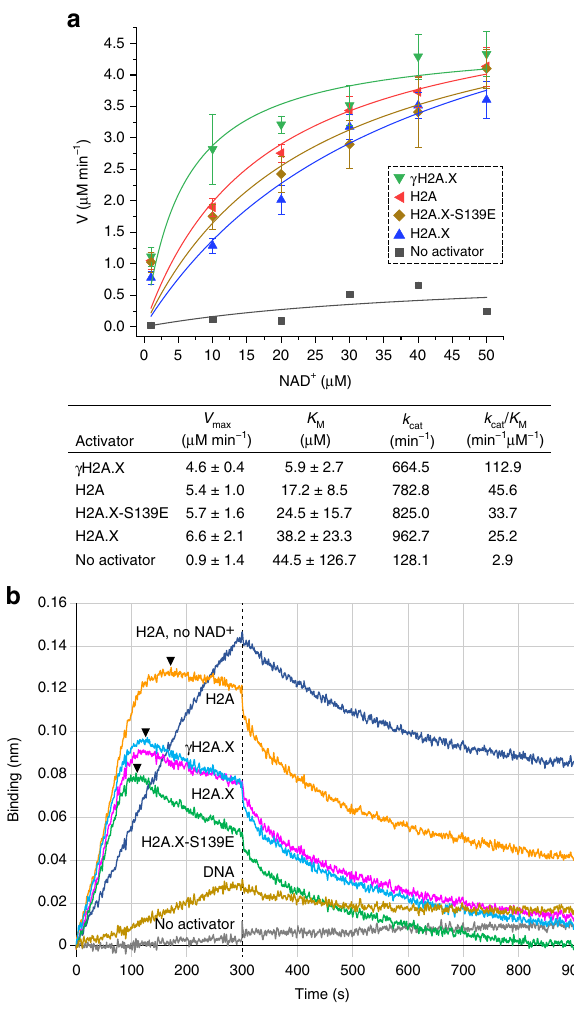
Fig. 5 In fl uence of activator binding on PARP1 catalytic activity and vice versa. a Catalytic pro fi le and parameters for PARP1 activation by H2A and H2A.X nucleosomes (mean ± s.d., n = 2 independent experiments). b Effect of auto-PARylation on activator binding behaviour. BLI measurements were performed in the presence of 100 μ M NAD + (with exception of uppermost sample), with PARP1 and either no activator, naked DNA or H2A or H2A.X nucleosome. Probes were switched to analyte(activator)-free conditions after 300 s (dashed line). Arrowheads indicate approximate in fl exion points, coinciding with observable dissociation, for H2A and H2A.X Data fi